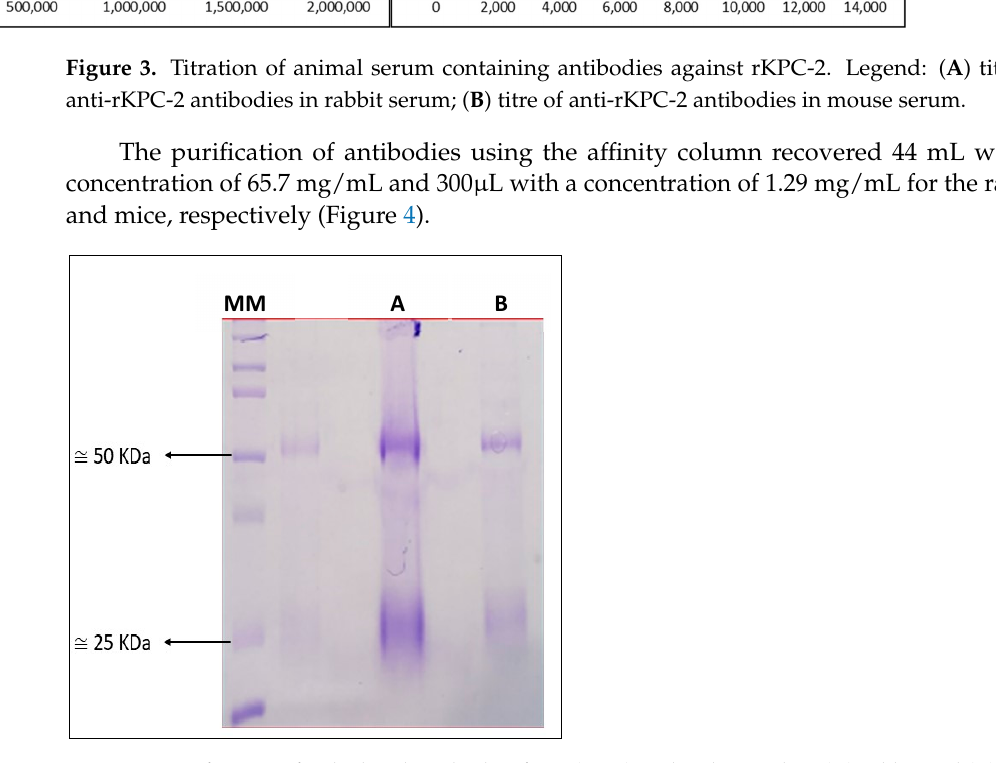
Figure 4. Purification of polyclonal antibodies from ( MM ) molecular marker; ( A ) rabbit and ( B ) mice on SDS–PAGE gel. Antibodies have two subunits, one with 50 KDa and the other with 25 KDa. The cross-reactivity between pAbs of mouse rKPC-2-pAb and rabbit rKPC-2 for cap- ture ELISA was investigated, and the best concentration chosen was 6.25 µg/mL for both pAbs, which presented the lowest acceptable recognition among the pAbs (cross-reacting) without losing the ability to recognise the studied antigen (rKPC) (Table 3). Table 3. Results of the block titration. Average of three block titration assays to de fi ne optimal mouse and rabbit pAb concentrations to be used in the ELISA test. Legend: A : titration using PBS; B , titra- tion using rKPC-2. * We used the 6.25 µg/mL mouse pAb dilution and also 6.25 µg/mL rabbit pAb.